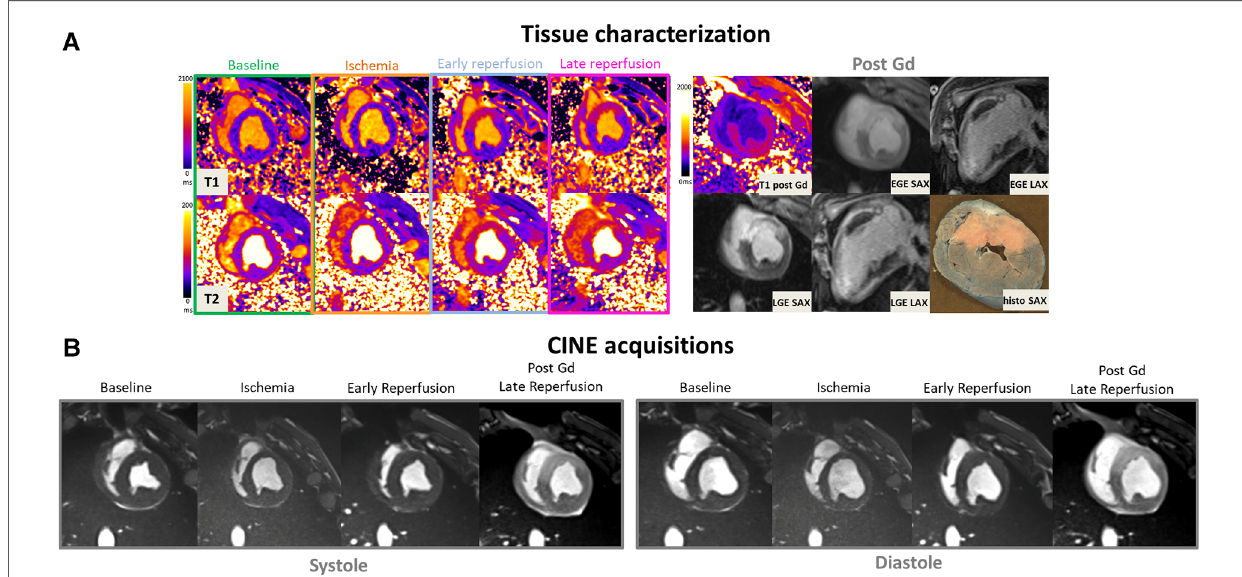
FIGURE 2 ( A : top left) Representative short-axis T1 and T2 maps obtained at baseline, during ischemia, early, and late time-points of the reperfusion in a swine open chest model from the treated SW group. ( B ) CINE bSSFP images are displayed in short axis, in diastole and systole at different time-points. ( A : top-right) Early and late Gadolinium enhanced images (EGE and LGE) matching to the corresponding T1 maps, together with ex vivo macroscopic corresponding mid-ventricular slice after Evans blue dye are also displayed (top-right). Gd hyper-enhanced sectors in post-contrast bSSFP images can be easily identi fi ed, visually matching the EGE and LGE hyperintense areas. These sectors correspond to akinetic segments during ischemia but also where edema immediately and clearly appeared after reperfusion on both T1 and T2